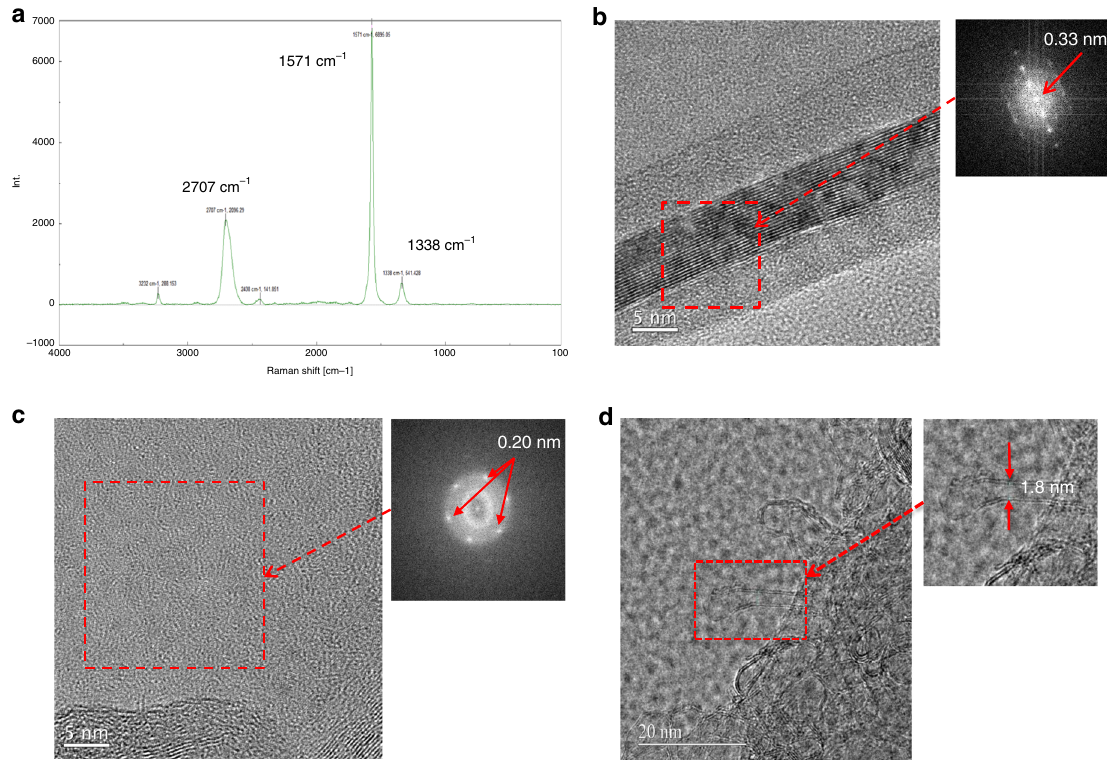
Fig. 4 Raman spectra and HRTEM images (and their power spectra) of carbon allotropes. a Raman spectrum of graphite-containing sample. b HRTEM image and power spectrum of graphite-containing sample corresponding to the (002) lattice plane. c HRTEM image and power spectrum of graphite- containing sample corresponding to the (100) lattice plane. d HRTEM image of carbon nanotube-containing